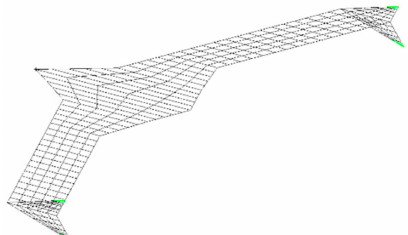
Figure 6. Aerodynamic lifting surface model of BFF wind tunnel test